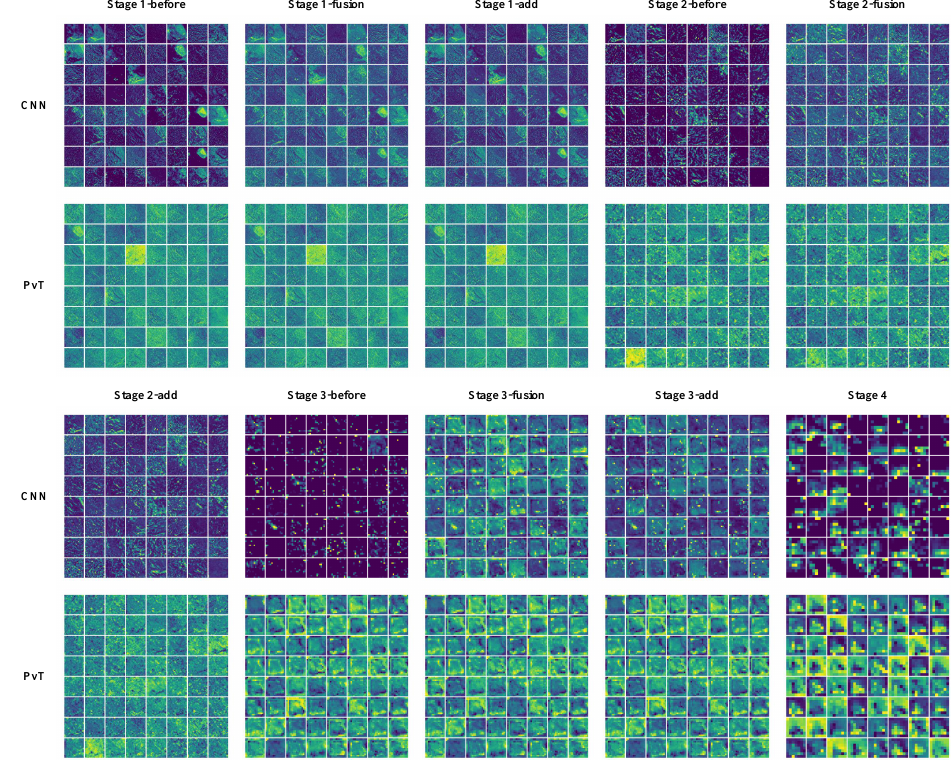
Figure 10. Partial feature maps before and after fusion at each stage. before: feature maps before fusion, fusion: feature maps after fusion, add: the blended features are superimposed on the original image and are also the input for the next stage.